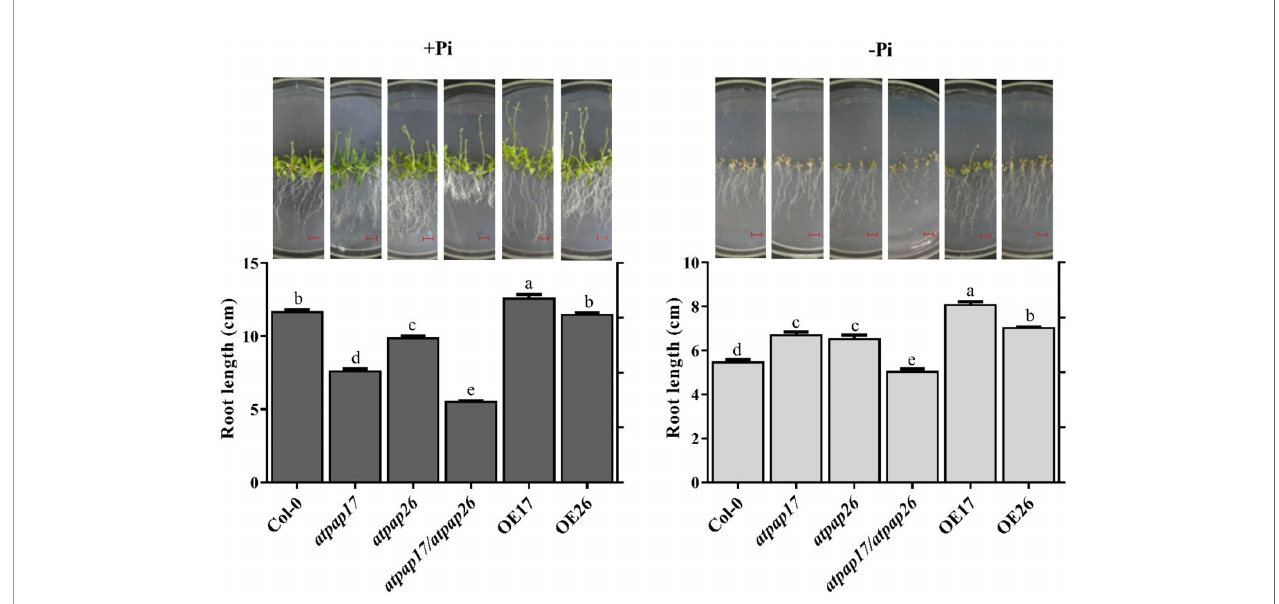
FIGURE 8 | Main root length and morphology of Col-0, AtPAP17 and AtPAP26 mutants ( atpap17 , atpap26 , and atpap17/atpap26 ) and overexpressing lines (OE17 and OE26) (each overexpressed line includes four independent transgenic lines) grown under +Pi (1.25 mM KH 2 PO 4 ) and − Pi (no Pi) conditions. All lines were grown for 21 days on vertically oriented MS agar plates as described in the Materials and Methods . The pictures of plants grown under +Pi and − Pi are shown at the above columns. Values are the means ± SE of three biological replicates and each replicate is the mean of 12 seedlings. Signi fi cant differences are indicated by different letters above the bars ( P < 0.05). Scale bars = 2